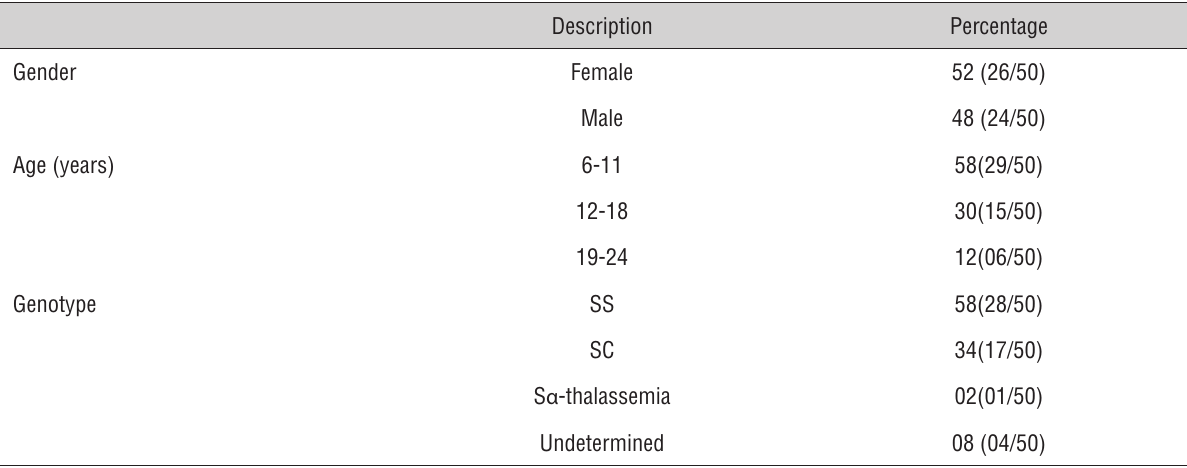
Table 1- General characteristics of the study population